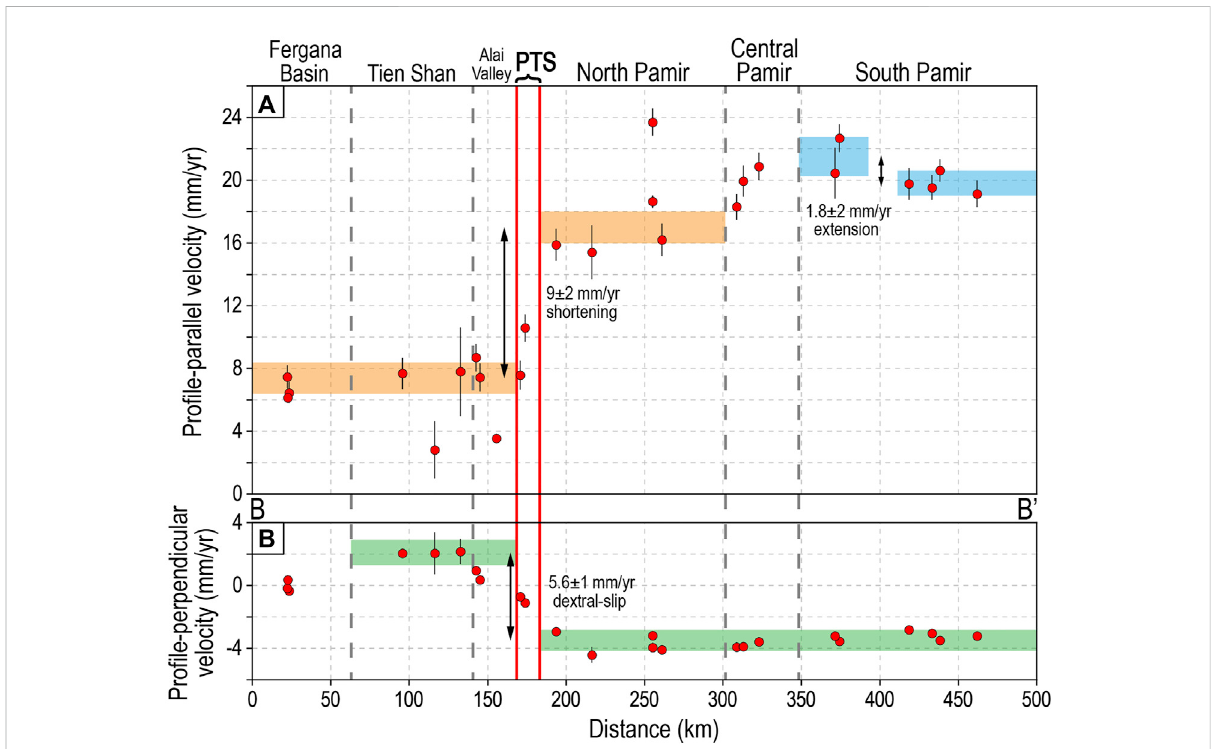
FIGURE 5 GPSvelocitypro fi leB – B ’ (seelocationinFigure3). (A) Velocitiesparalleltothepro fi le. (B) Velocitiesperpendiculartothepro fi le.Coloredstripes showvelocityranges.Thedarkgreydashedlinesandboldredlinesmarkthetectonicdomainboundariesandfaultlocations,respectively.PTS:Pamir Thrust System. Other fault names same as Figure